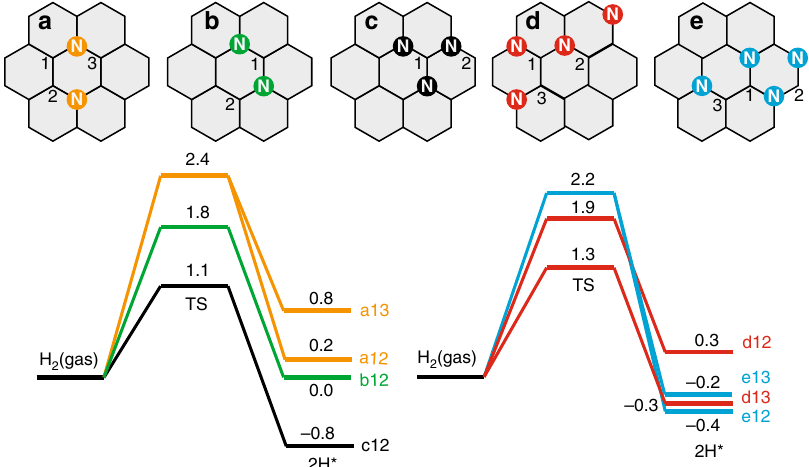
Fig. 4 DFT calculations of activation of H 2 molecules on clustered N sites. The location of the sites for dissociated hydrogen is labeled by numbers and used in the plot of the energy pro fi le. The values are in